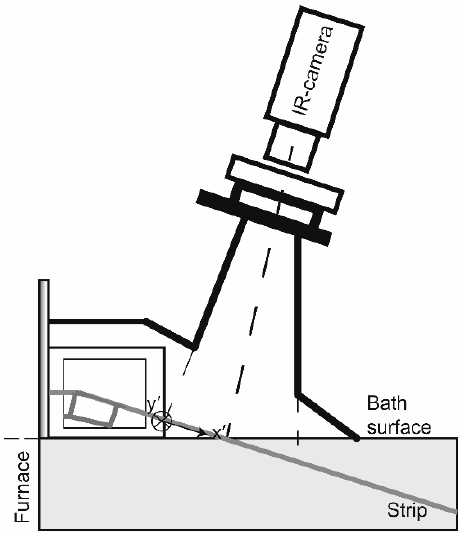
Figure 3. Schematic view of the temporary measurement setup used in the industrial hardening process.